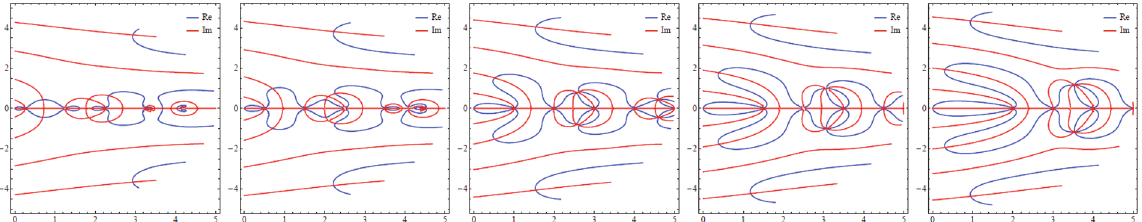
Figure 3. Graphical solution of Eq. (7) illustrated for x − = − 2, x ↓ = − 1, x ↑ = 1, x + = 2, τ = 1 and r = 0.5, 1, 1.5, 2 from left to right, respectively. Plotting conventions are the same as in Fig.